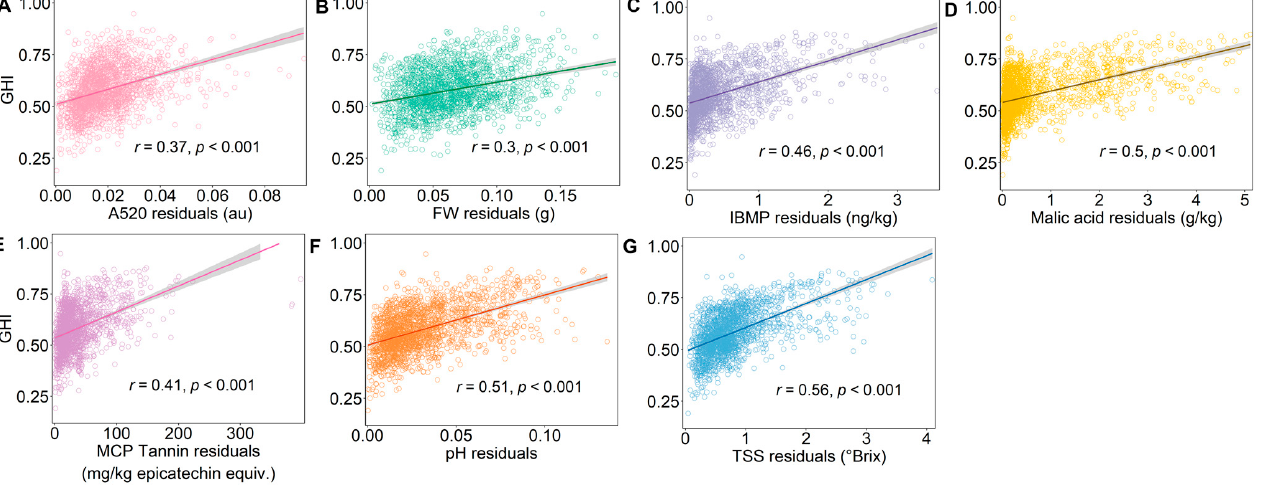
Figure 7. Sensitivity analysis achieved using scatterplots showing the relationship between bunch- to-bunch (i.e., within a vine) GHI score and residuals from linear-mixed models for ( A ) absorbance at 520 nm (A520), ( B ) berry fresh weight (FW), ( C ) 3-isobutyl-2-methoxypyrazine (IBMP), ( D ) malic acid, ( E ) methyl cellulose precipitable (MCP) tannin, ( F ) pH, and ( G ) total soluble solids (TSS). Linear fits (–) are graphed to aid visualisation of the relationship between variables, with Pearson correlation coefficient (r) and p -value indicating the strength and significance of the relationship.